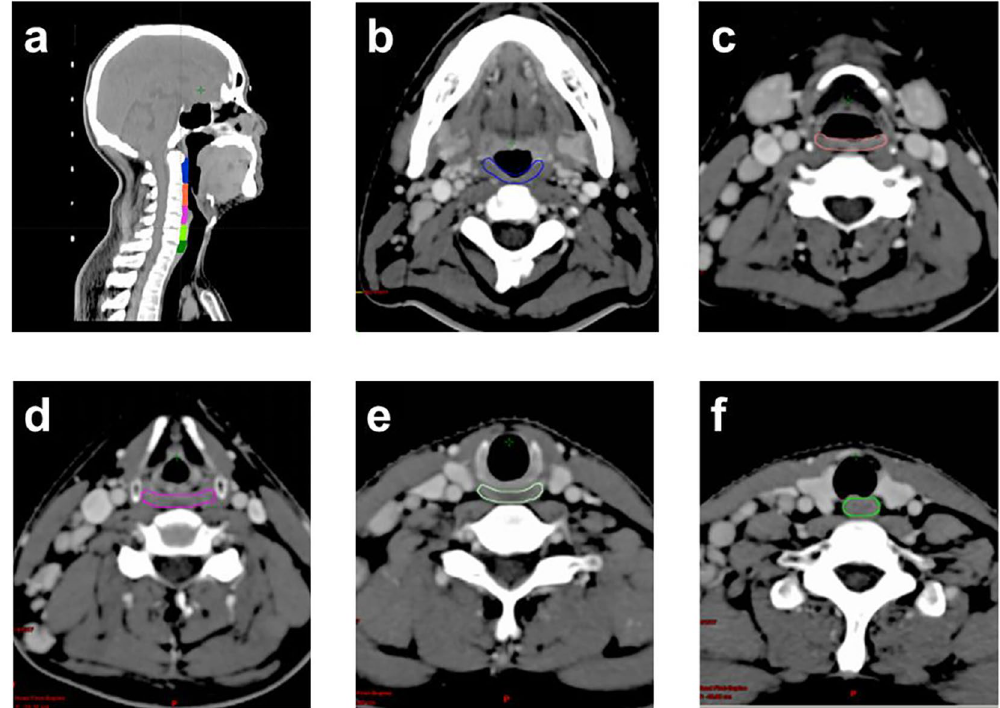
Figure 1. Anatomical delineations of the SWOARs. ( a ) Delineations on sagittal CT-slices. ( b–f ) The contours of the SCM, MCM, ICM, CPM and EIM on axial